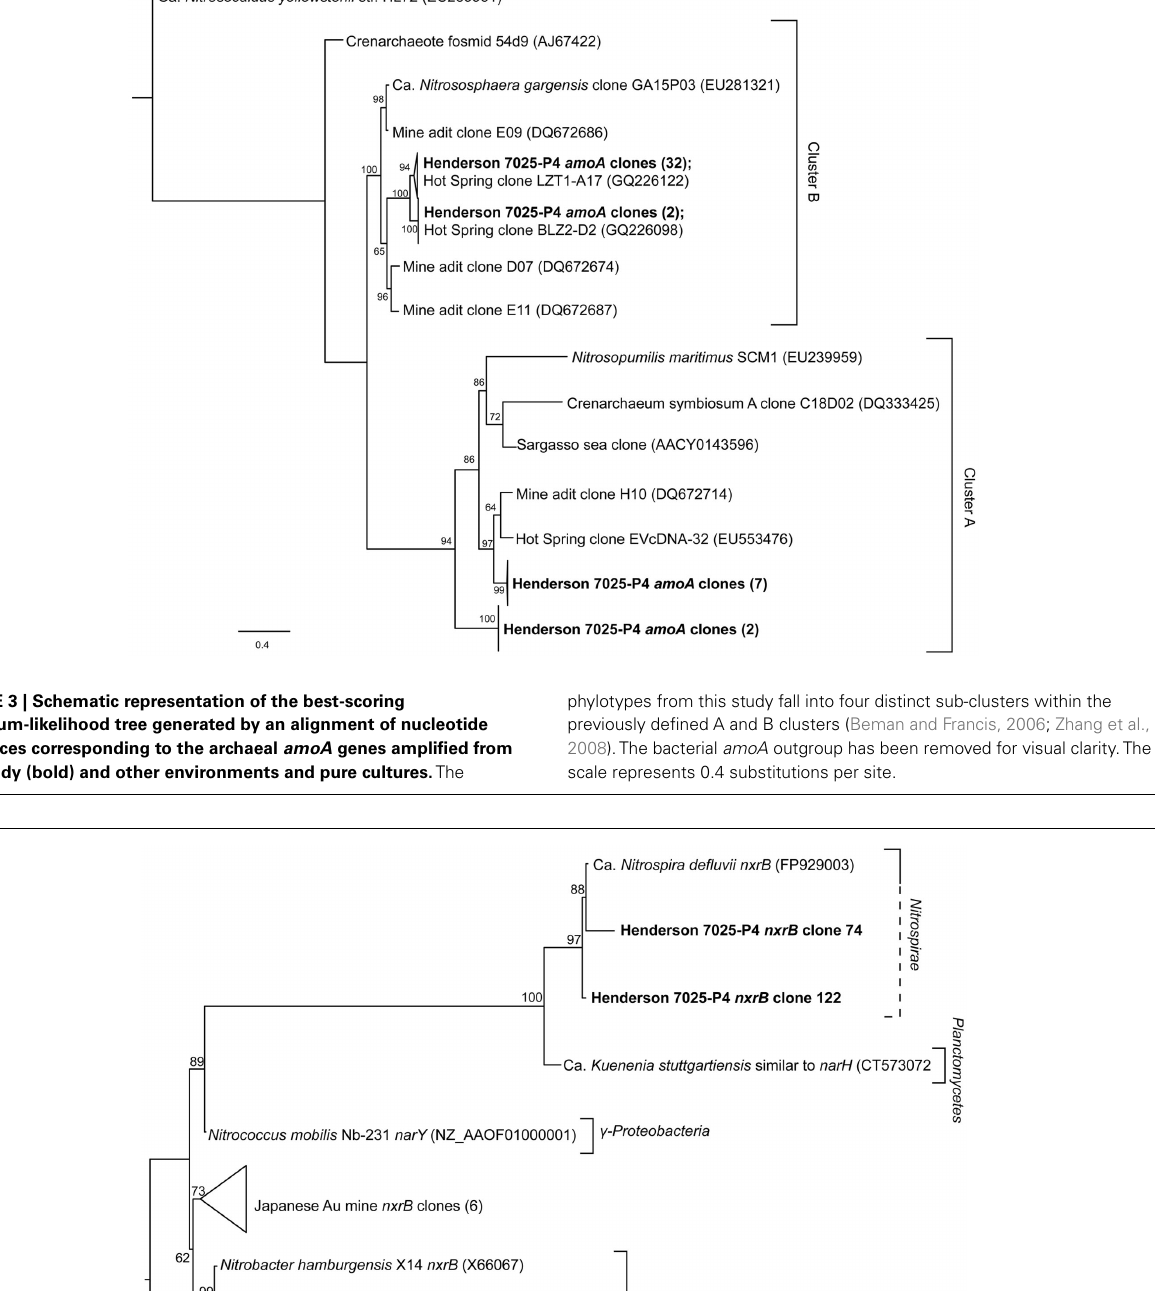
relationship is supported by high bootstrap values.The other nxrB sequences belong to organisms of the Proteobacteria , except for the Japanese Au mine clones (Hirayama et al., 2005), whose phylogenetic affiliation is unknown. Scale bar represents 0.6 substitutions per